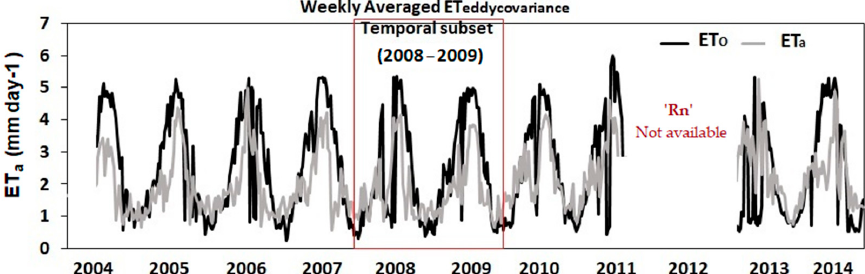
Figure 2. Weekly averaged reference evapotranspiration (ET o ) and actual ET (ET a ,) obtained from eddy covariance meas- urements for the IT_BCi buffalo farm covering the entire site-surveillance period (Jan 2004 to Dec 2014). The gap exists in eddy covariance measurements for the IT_BCi buffalo farm covering the entire site-surveillance ET estimation due to the unavailability of net radiation (Rn) in Jan–Apr 2004 and Sep 2011–Apr 2013 in the eddy covariance period (January 2004 to December 2014). The gap exists in ET estimation due to the unavailability data.